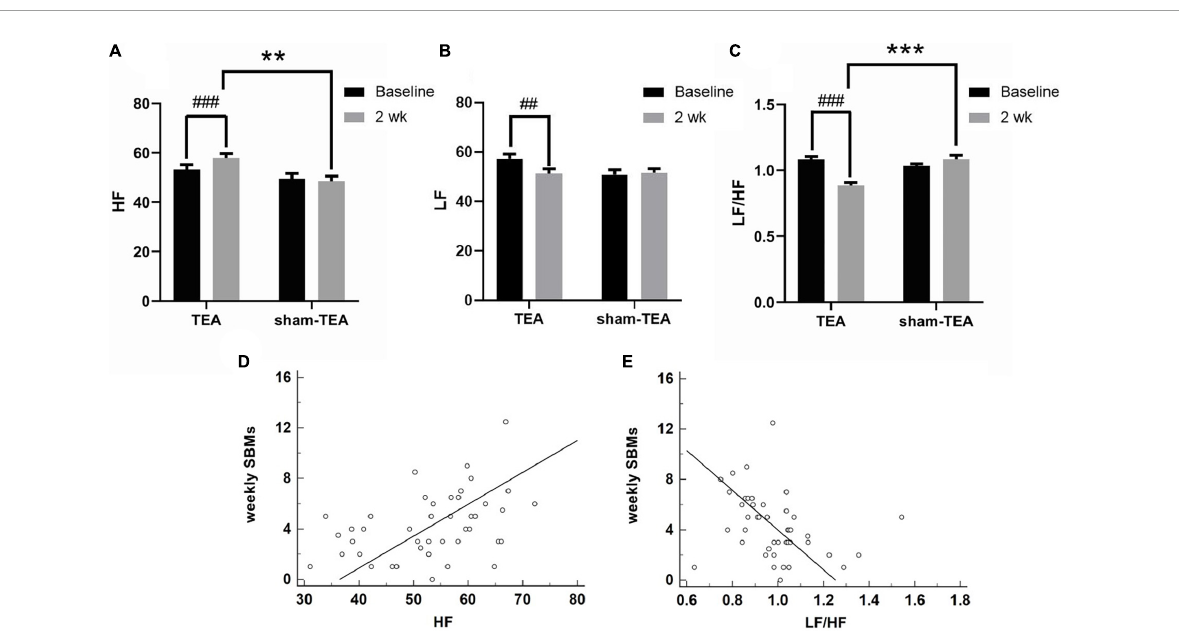
FIGURE4 Effects of TEA on autonomic function. The HF (A) , LF (B) and LF/HF ratio (C) in TEA group and sham-TEA group after 2 weeks of treatment (vs. baseline, ## P < 0.01, ### P < 0.001; vs. sham-TEA, **P < 0.01, *** P < 0.001). The correlation between weekly SBMs and HF (D) . The correlation between weekly SBMs and the LF/HF ratio (E)